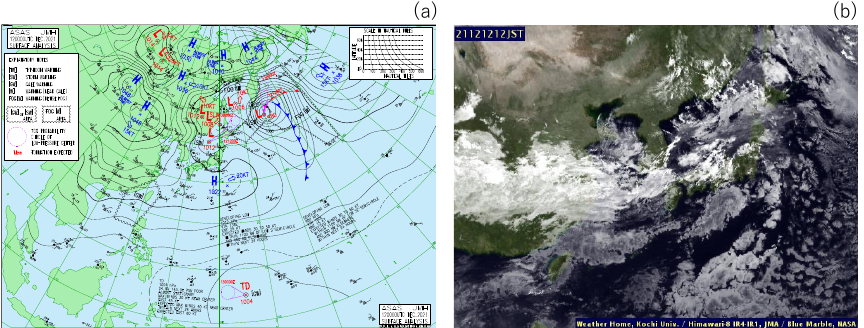
Figure 10. All-sky camera images at CHF around the time of EQ2: ( a ) 1.5 h before the EQ, ( b ) 30 min before the EQ, and ( c ) 30 min after the EQ. Figure 11. ( a ) Weather map and ( b ) IR weather satellite image around the time of EQ2.